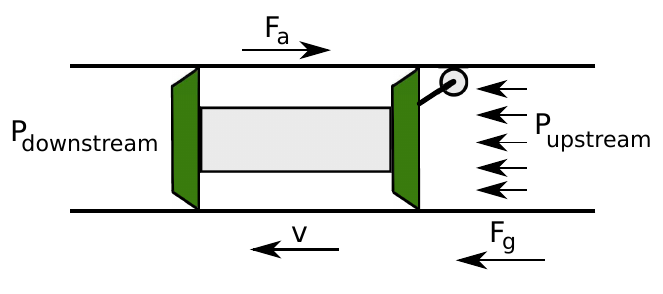
Figure 2. Forces exercised on the PIG. Source: By